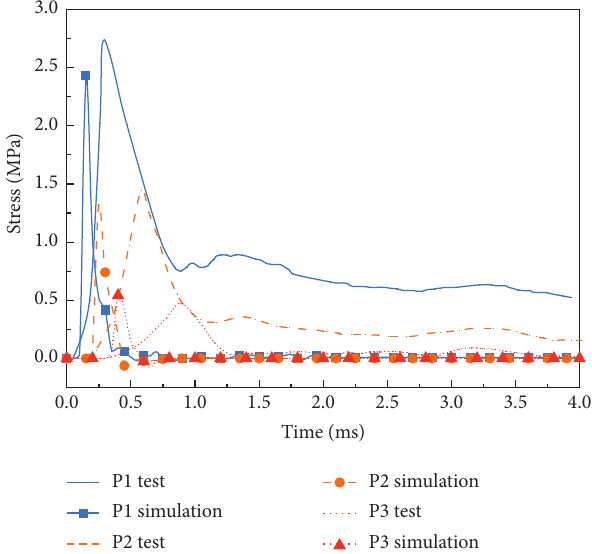
Figure 5: Comparison of stress-time curves at measuring points between simulation and test.